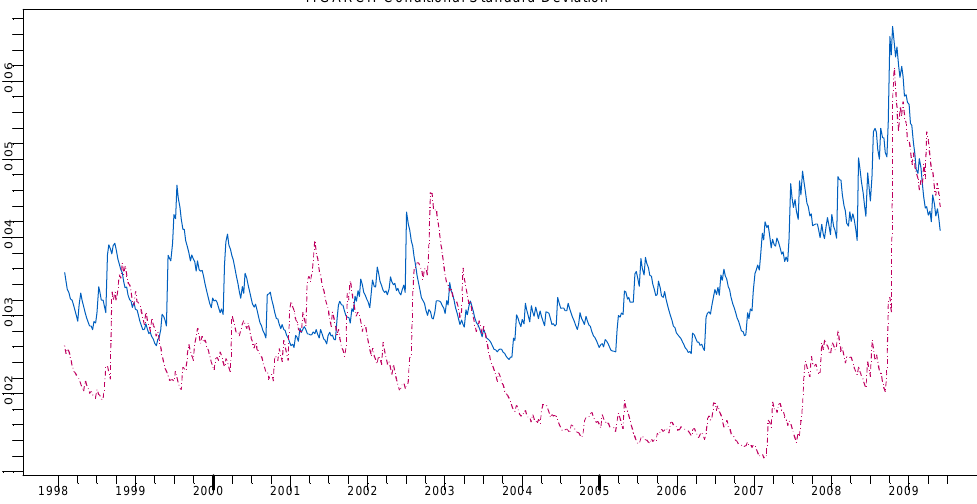
MGARCH Conditional Standard